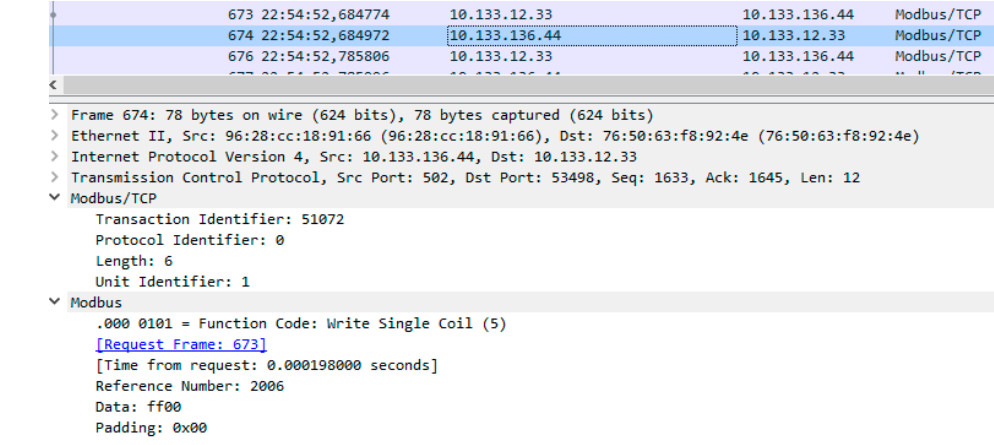
Figure 2. Modbus communication example.